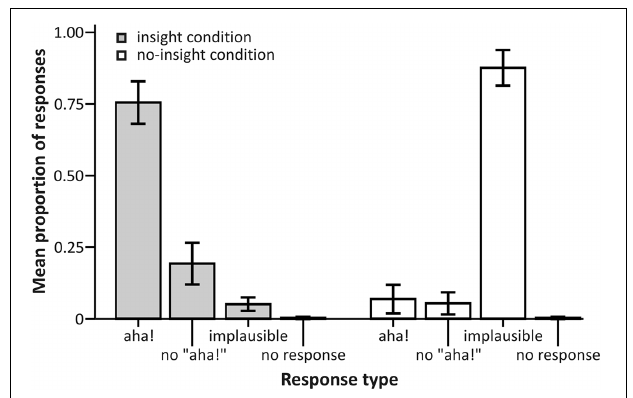
FIGURE 2 | Proportion of responses for each experimental condition. Error bars represent 95% confidence